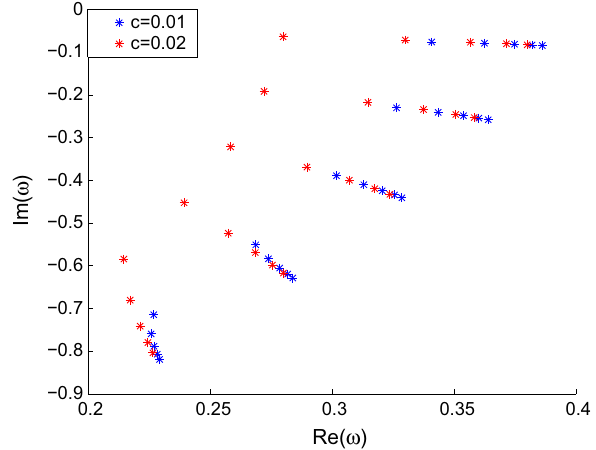
Fig. 2 Behavior of the quasinormal frequencies for l = 2